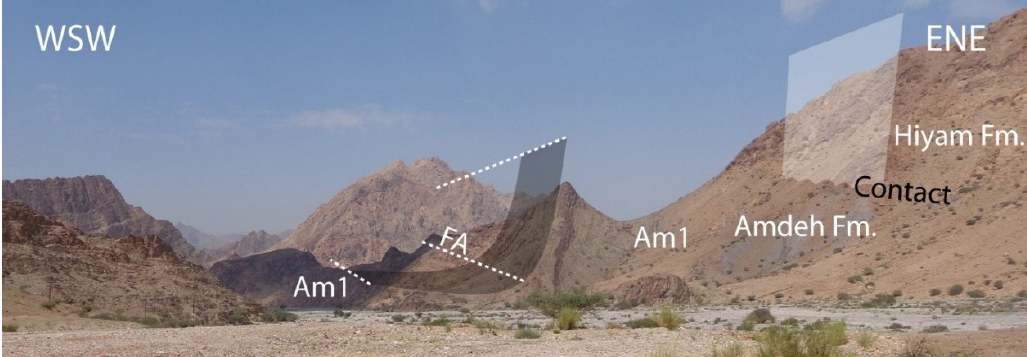
Figure 3. Structural and stratigraphic overview in Wadi Amdeh. To the ENE, the light transparent Figure 3. Contact between the Amdeh and Hiyam formations. The contact is marked by the sinistral surface marks the contact between the Amdeh and Hiyam formations. This contact between the older Wadi Amdeh Fault (dashed white line). Note the slickenlines between the two black dashed lines. The Hiyam Formation and the younger Amdeh Formation is a steeply dipping fault as indicated by the two white arrows point to the red cataclasite / tectonic breccia in close proximity to the fault. Note that dip of the light transparent surface and is described in Section 5.2 as the “Wadi Amdeh Fault”. This the red cataclasite / tectonic breccia is obliquely oriented to the fault, being in contact with the fault in the foreground and separated from the fault in the background. Coordinates of the fault: 23 ◦ 19 (cid:48) view shows Am 1 which displays a large open syncline (dark transparent curved surface) with a fold 45.12”N / 58 ◦ 23 (cid:48) 43.95” axis (FA) oriented (331/03). It is the largest fold we encountered. From the Wadi to the Hiyam/Amdeh contact, the beds of Am 1 become increasingly older. In the subsurface, this contact is an angular unconformity (compare [4]). Coordinates of the depicted section: 23°19'43.68" N/58°23'37.78" E.